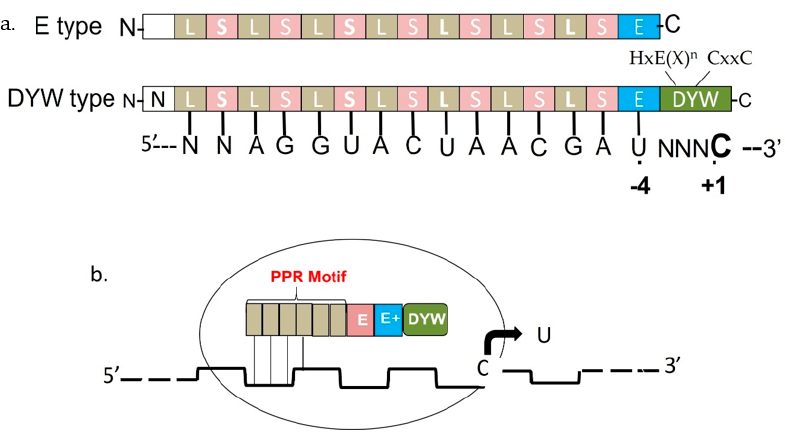
Figure 5. ( a ). Schematic domain structure of PPR editing proteins that consist of PPR motifs (P, L, S), and additional C-terminal domains (E and DYW), ( b ). Involvement of a DYW-type PPR protein in C to U RNA editing [95].